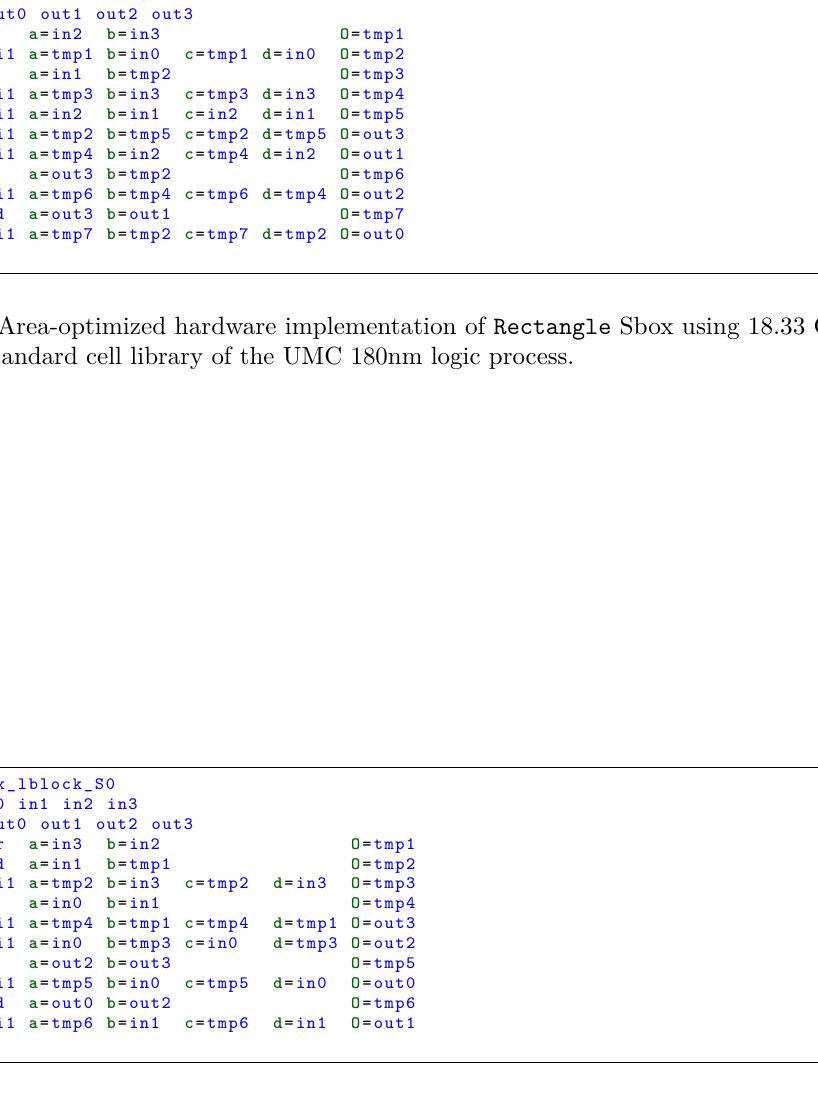
Figure 9: Area-optimized hardware implementation of LBlock S 0 Sbox using 16.33 GE with the standard cell library of the UMC 180nm logic